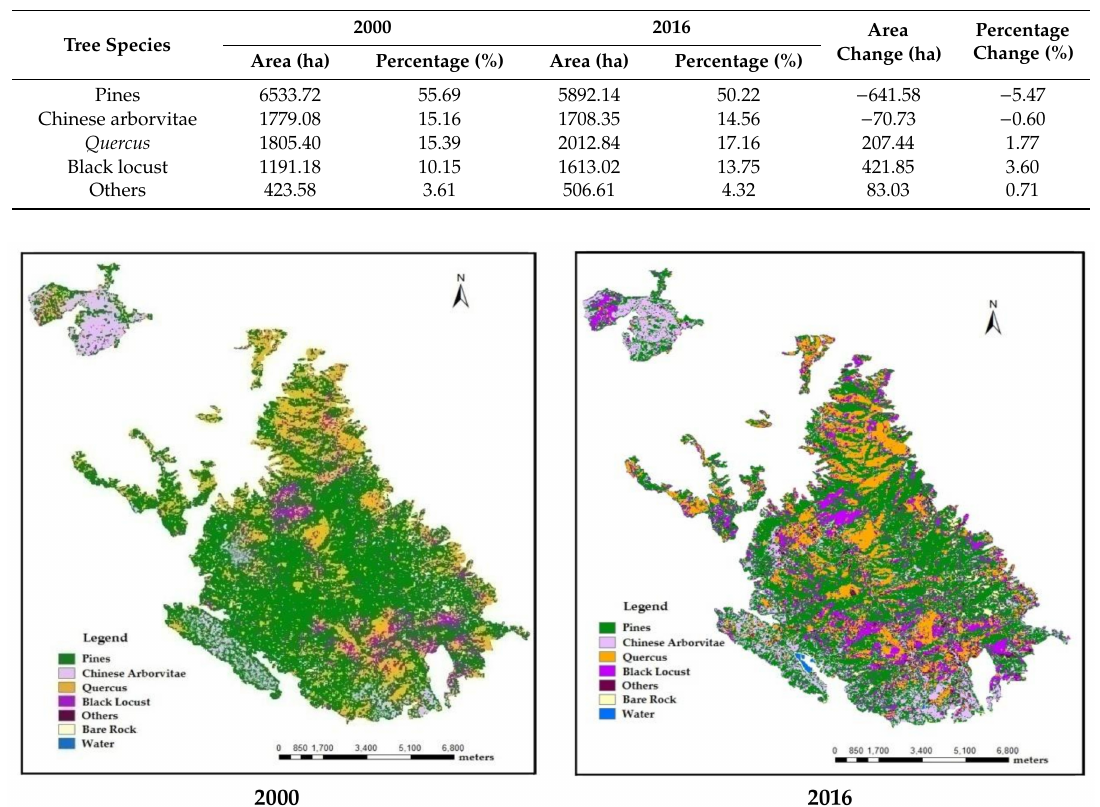
Table 3. Statistical table of area and percentage of each tree species.